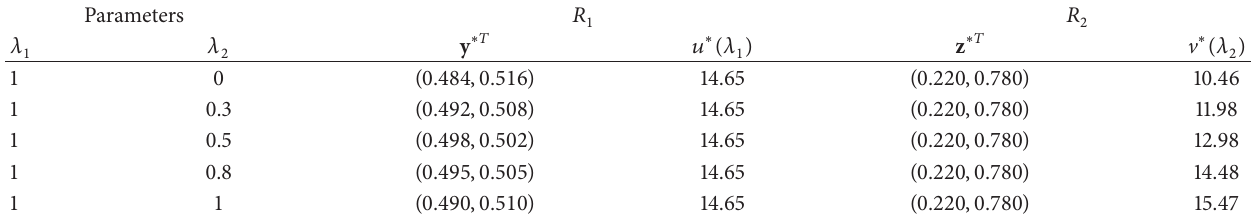
Table 3: Satisfying Nash equilibrium values and corresponding strategies of commerce retailers.